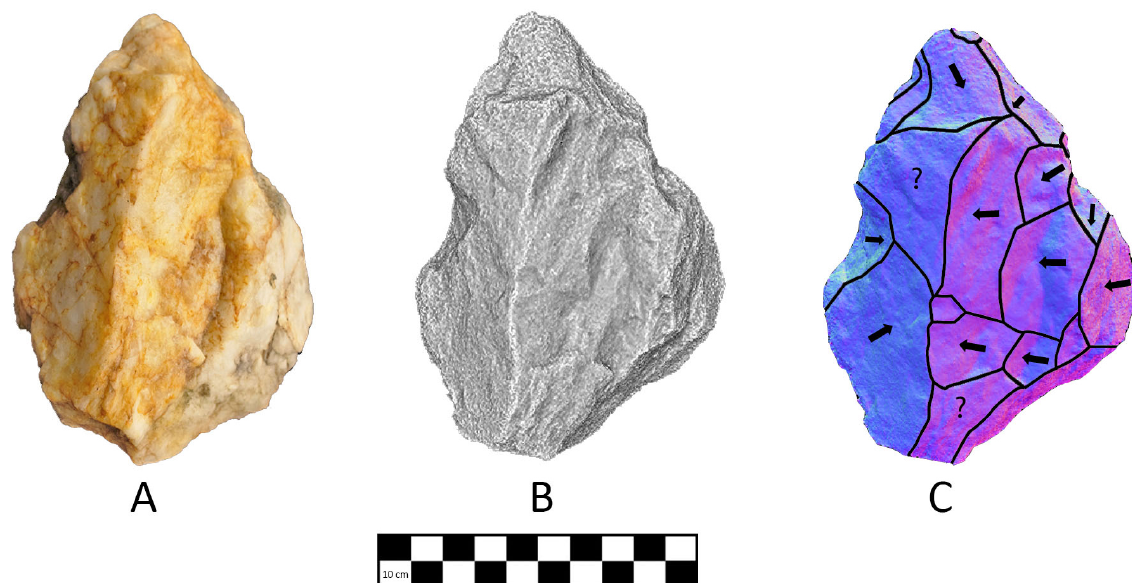
Figure 2. Handaxe (biface): A. photograph; B. photorealistic model with Radiance Scaling surface enhancement to reveal surface removals (Vergne et al . 2010); C. photorealistic model with normal shader with flake removal boundaries marked by black lines; arrows indicate the direction of flaking. Colours illustrate the distribution of light (blue = less light; red = more light) revealing undulating surfaces created by flake